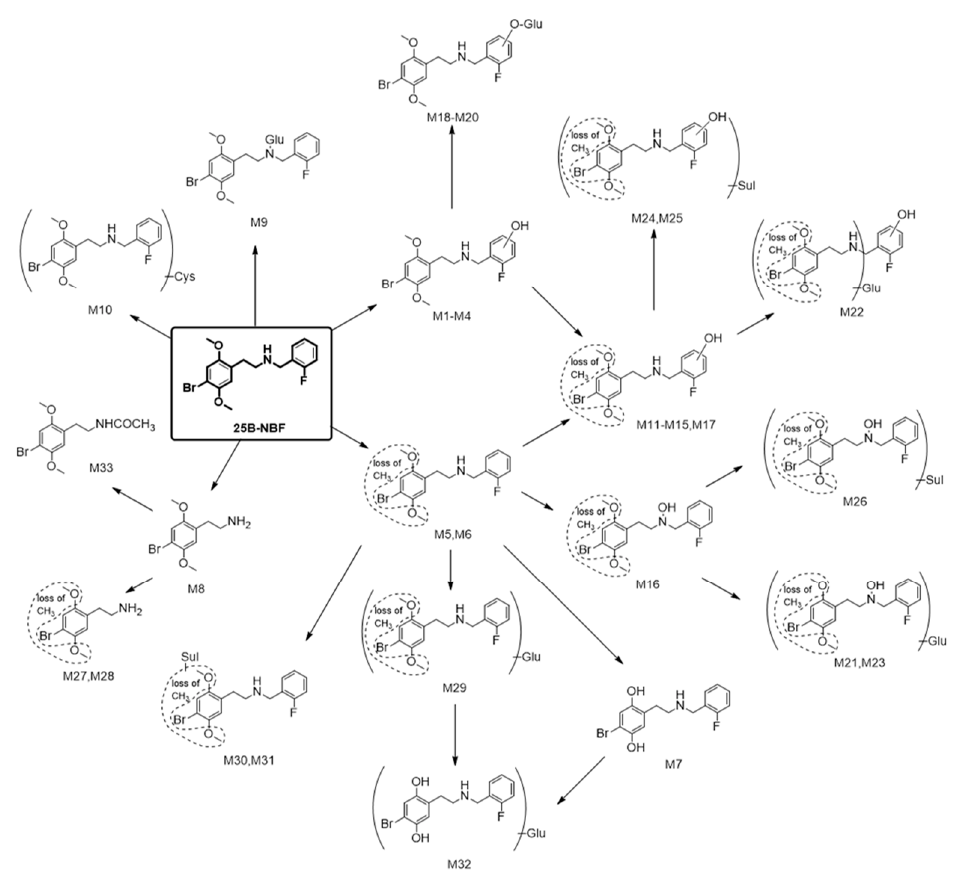
Figure 5. Proposed metabolic pathways of 25B-NBF in human hepatocytes. Glu: Glucuronide; Sul: Sulfate; Cys: Cysteine.